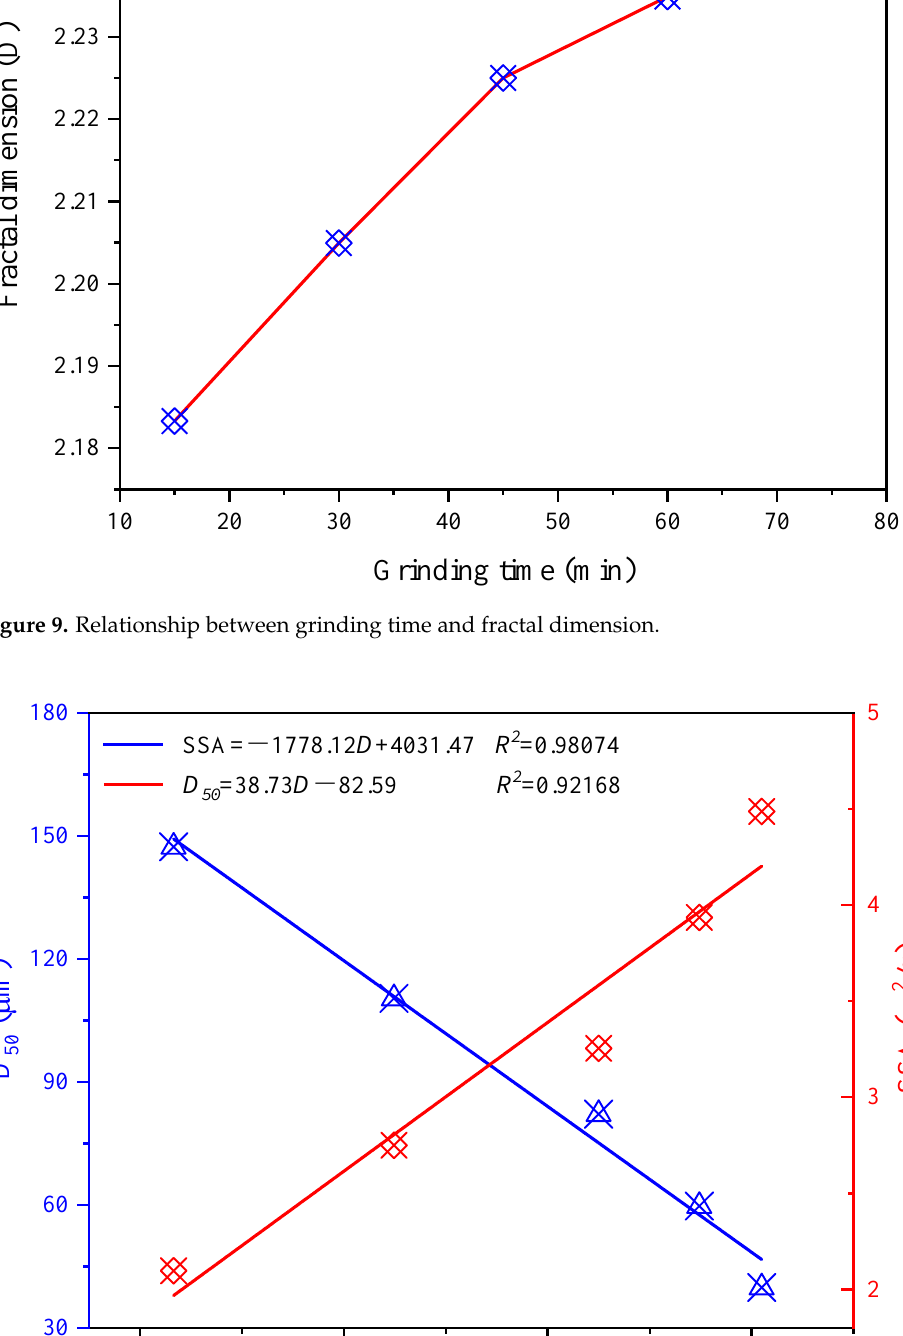
Figure 9. Relationship between grinding time and fractal dimension.